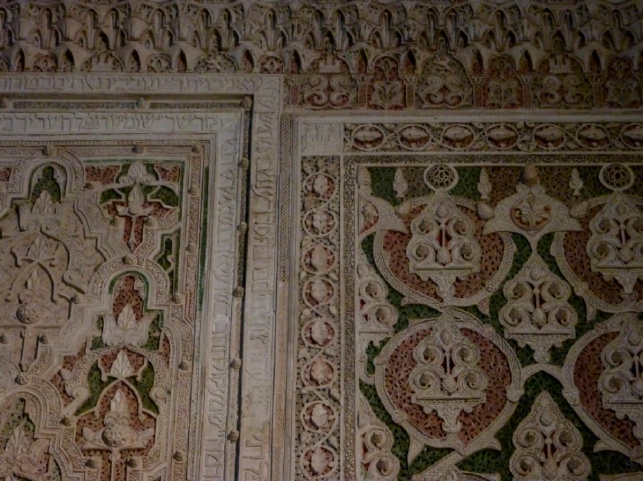
Figure 17. Detail of the heikhal of El Tránsito Synagogue. Author’s photo.